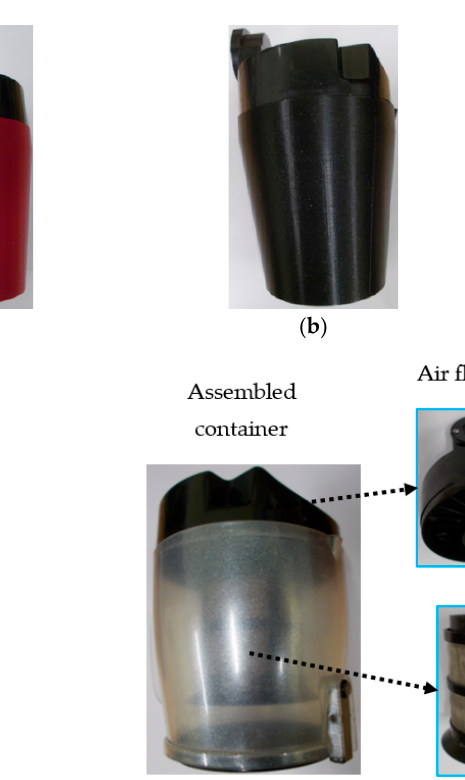
Figure 7. ( a ) Dimensions of the container for circulation of the tested mixed polymers and ( b ) movement of polymer particles during the tribocharging process.